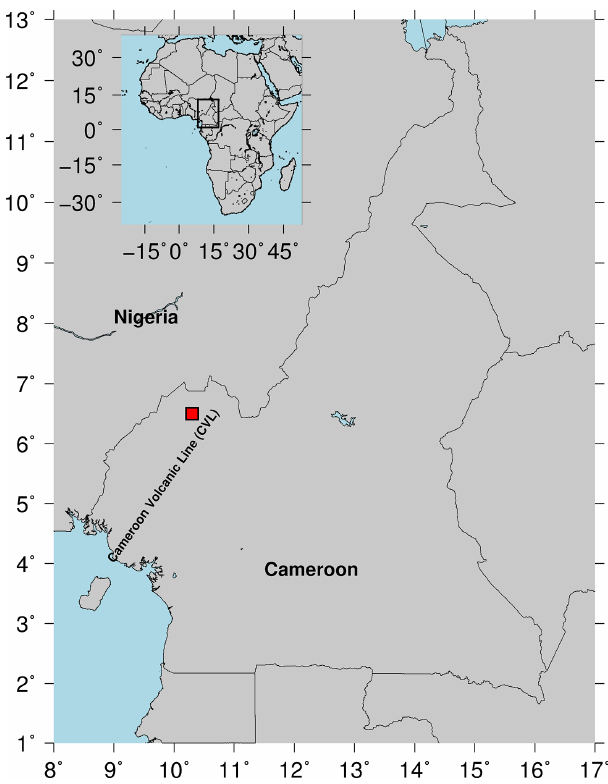
Figure 2. Map of Cameroon showing the Lake Nyos area (red